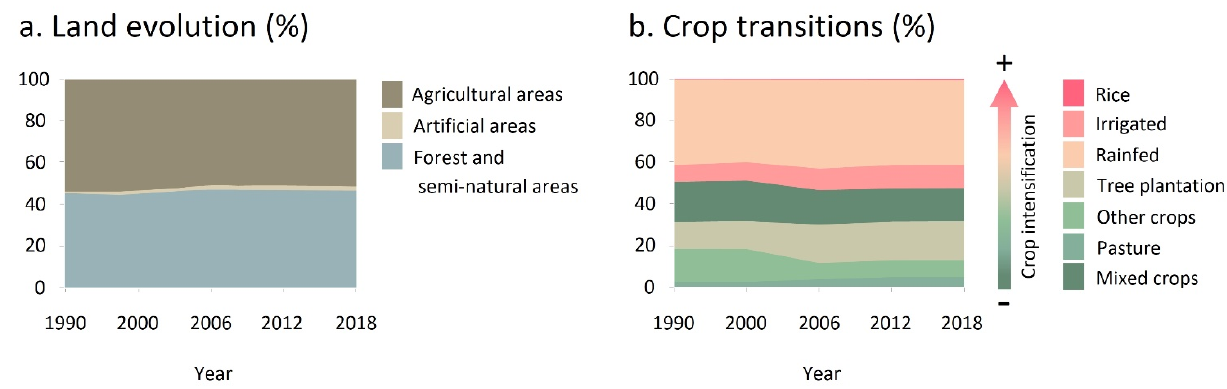
Figure 5. Evolution of changes in use in Spain between 1990 and 2018 according to CORINE. ( a ). Net change in natural and disturbed habitats. ( b ). Net evolution of the different types of agricultural use.